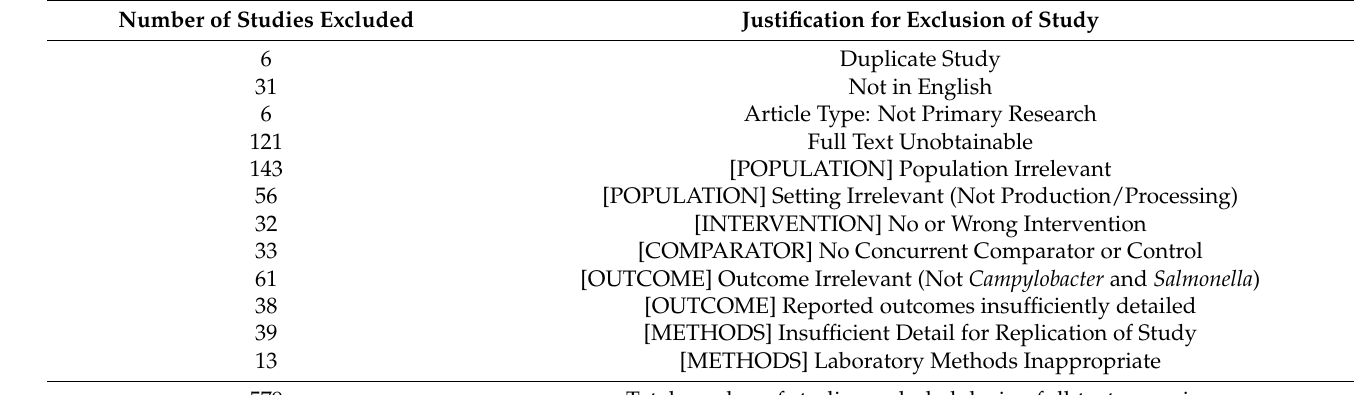
Table 1. Number of studies excluded at the full-text screening stage with justification. Note: one reason of exclusion was assigned to each excluded study. Values include studies from the updated vaccine search excluded due to article type ( n = 1), irrelevant population ( n = 18), wrong intervention ( n = 3), irrelevant outcome ( n = 9) and unclear intervention ( n =